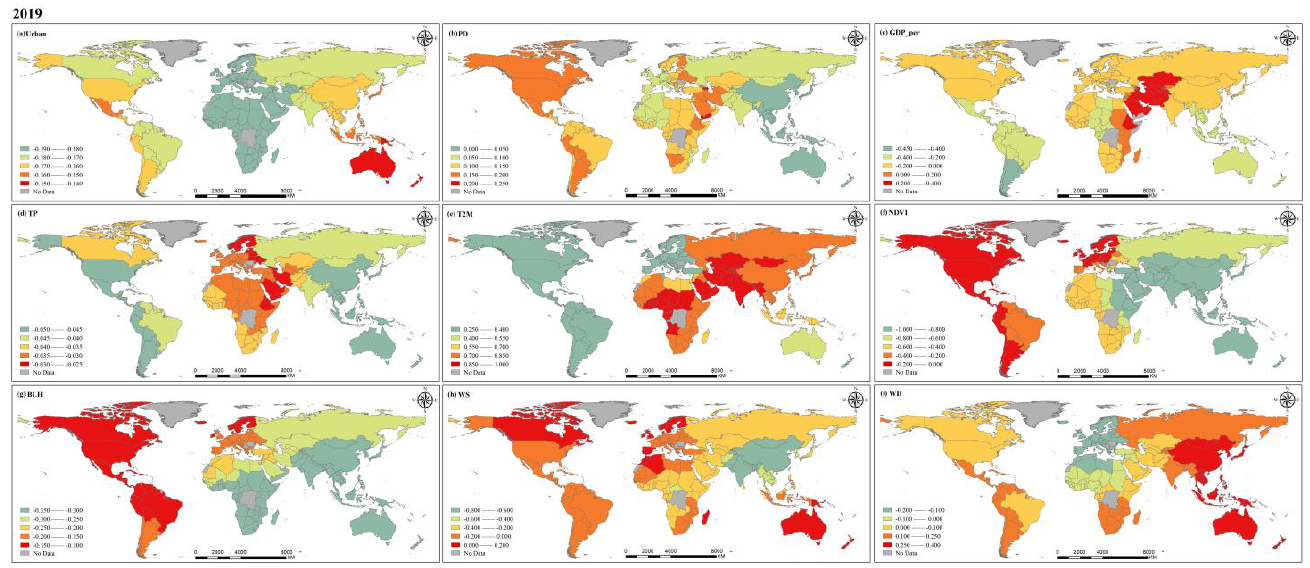
Figure 15. Spatial distribution of coefficients for factors in 2019.